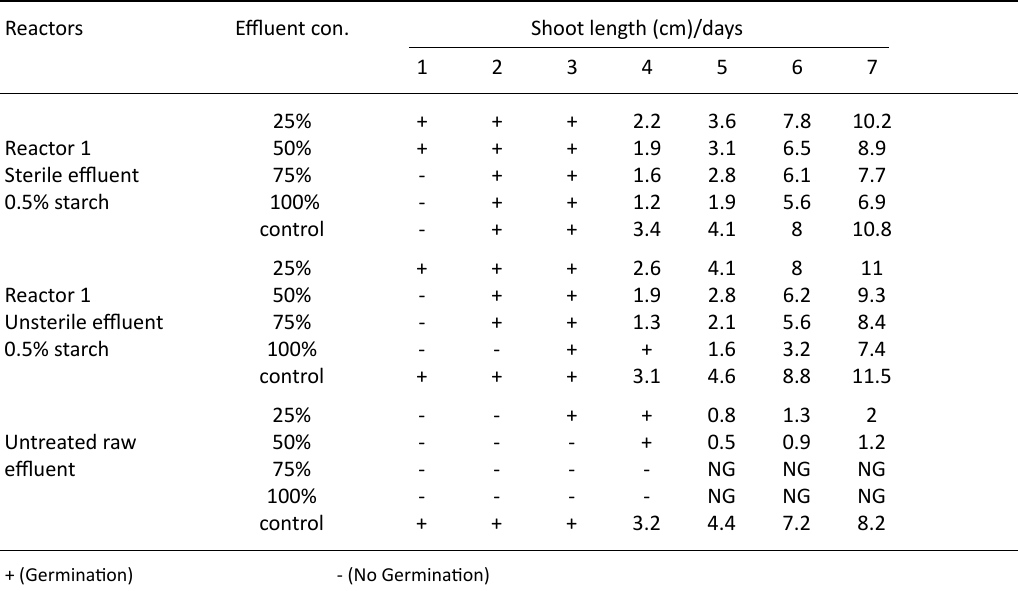
Table 2. Effectiveness of various concentrations of treated and untreated tannery effluent on germination and seedling growth of black gram ( Vigna mungo ) Reactors